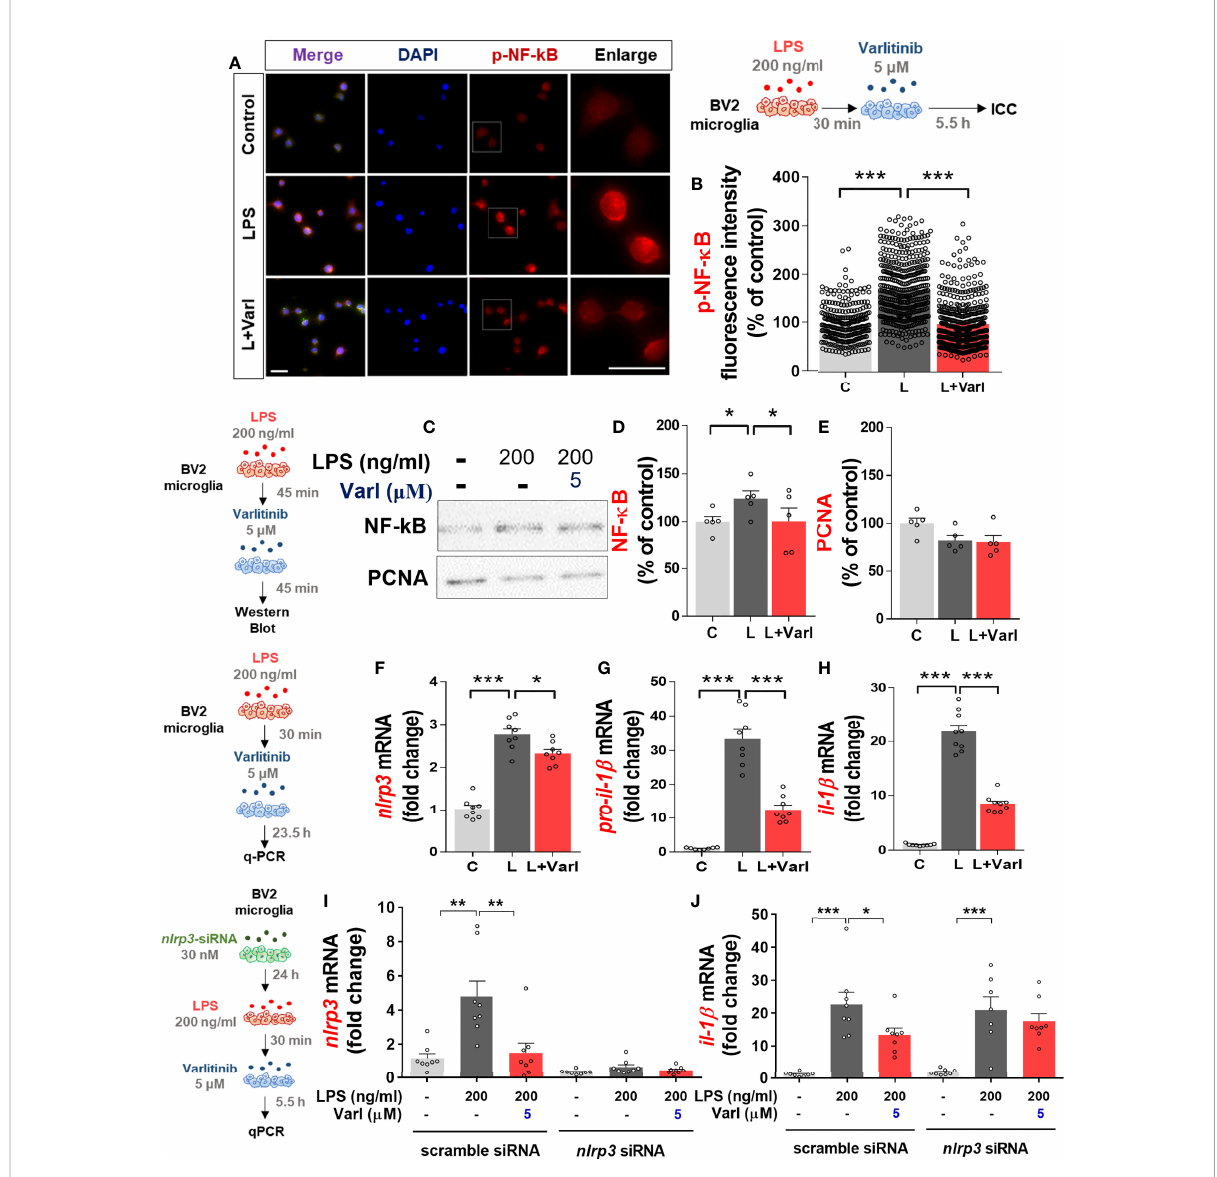
FIGURE 3 Varlitinib decreases LPS-evoked nuclear NF-kB phosphorylation and NLRP3 in fl ammasome activation in BV2 microglial cells. (A, B) Cells were treated with LPS (200 ng/ml) or PBS for 30 min and varlitinib (5 m M) or vehicle (1% DMSO) for 5.5 h, and immunostaining was conducted with an anti-p-NF-kB antibody (C: n = 274; L: n = 434; L+Varl: n = 481, total number of examined cells). (C – E) Cells were treated with LPS (200 ng/ml) or PBS for 30 min and varlitinib (5 m M) or vehicle (1% DMSO) for 5.5 h. The nuclear fraction was then used in western blotting with anti-NF-kB and anti-PCNA (nuclear marker) antibodies (C: n = 6; L: n = 6; L+Varl: n = 6, independent biological replicates). (F – H) Cells were treated with LPS (200 ng/ml) or PBS for 30 min and varlitinib (5 m M) or vehicle (1% DMSO) for 23.5 h, and proin fl ammatory cytokine levels were measured by real-time PCR ( nlrp3 , pro-il-1 b , and il-1 b : C: n = 8; L: n = 8; L+Varl: n = 8, independent biological replicates). ( I, J) Cells were pretreated with nlrp3 siRNA (30 nM) or scramble (control) siRNA for 24 h, treated with LPS (200 ng/ml) or PBS for 30 min, and treated with varlitinib (5 m M) or vehicle (1% DMSO) for 5.5 h. The mRNA levels of nlrp3 and il-1 b were analyzed by real-time PCR ( nlrp3 and il-1 b : C: n = 8; L: n = 8; L+Varl: n = 8, independent biological replicates). * p < 0.05, ** p < 0.01, *** p < 0.001, C: Control; L: LPS; L+Varl: LPS+Varlitinib. Scale bar = 20 m